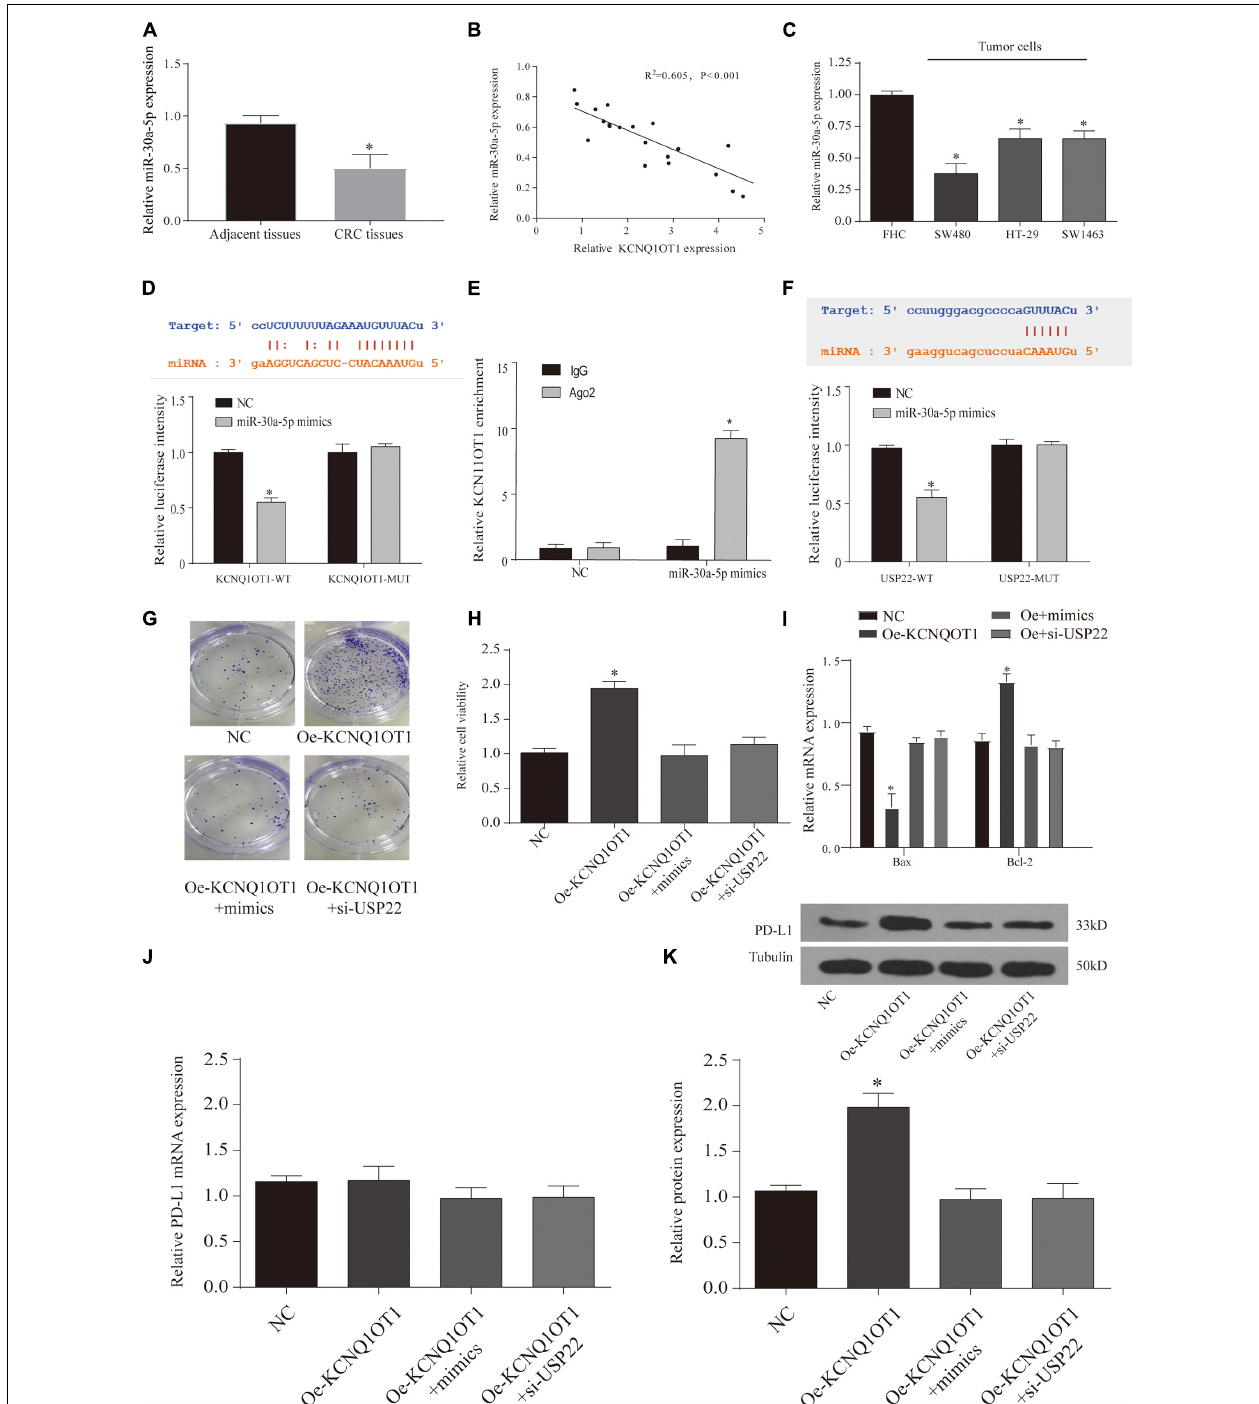
FIGURE 8 | Long non-coding RNA (lncRNA) KCNQ1OT1 regulates tumor cell immune escape via miR-30a-5p/ubiquitin-specific peptidase 22 (USP22) in the in vitro assay. (A) The expression of miR-30a-5p in patient samples. (B) The correlation between miR-30a-5p and lncRNA KCNQ1OT1 in tumor tissues. (C) Expression of miR-30a-5p in different types of colorectal cancer (CRC) cells. (D,E) . Dual-luciferase report and ribonucleoprotein immunoprecipitation (RIP) assay verify the targeting of lncRNA KCNQ1OT1 and miR-30a-5p. The binding site prediction comes from the Starbase database. (F) Dual-luciferase report verifies the targeting of USP22 and miR-30a-5p. The binding site prediction comes from the Starbase database. (G) Activated T cell and SW1463 cells were cocultured in six-well plates for 7 days, and then surviving SW1463 cells were visualized by colony formation assay. (H,I) T cell-mediated SW1463 cell killing analysis measured by Cell Counting Kit (CCK)-8 assay and detection of apoptotic protein. (J,K) Programmed death-ligand 1 (PD-L1) protein expression of SW1463 cells in different treatment groups. ∗ p < 0.05 compared with the relative control group.